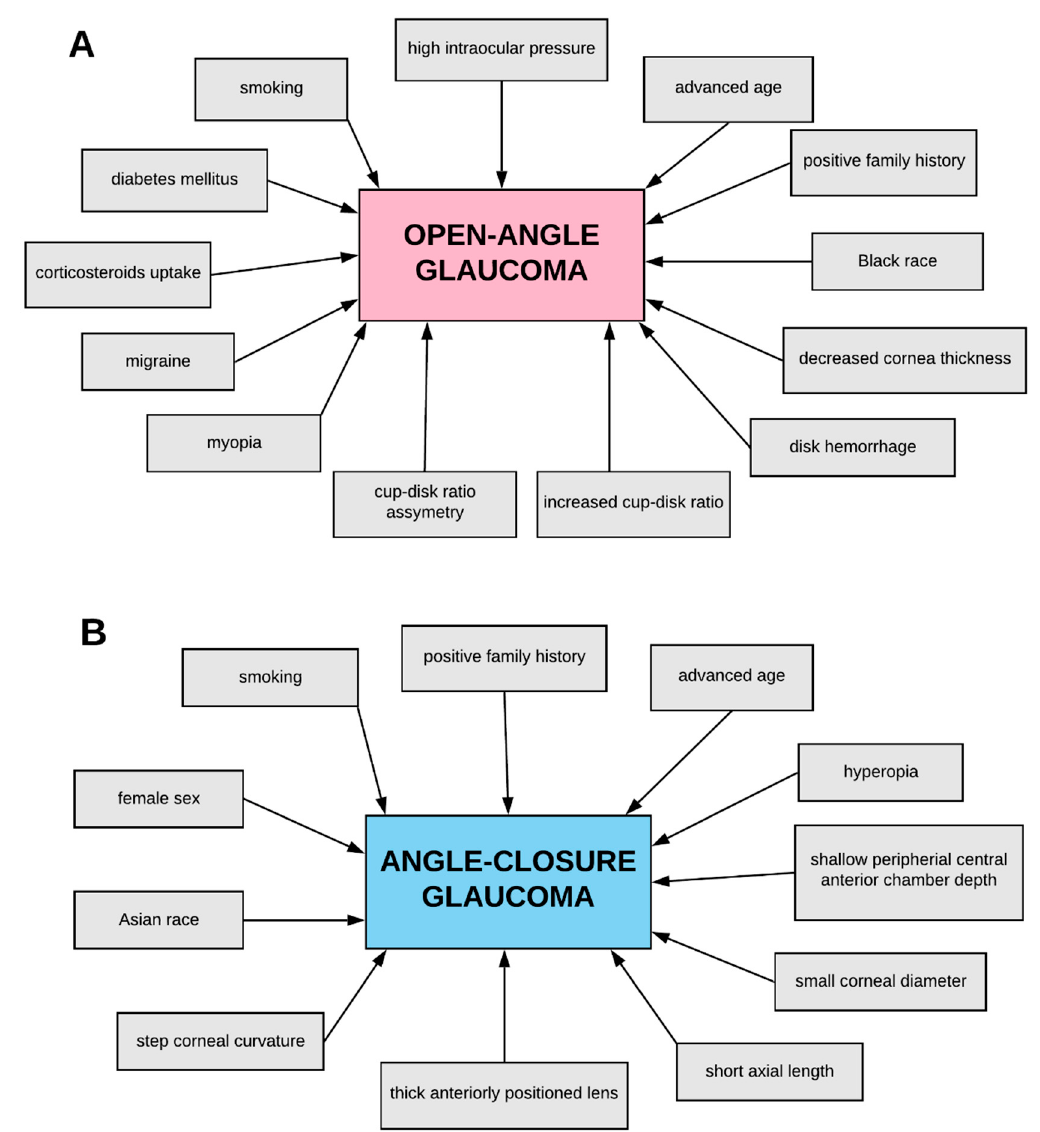
Figure 2. Risk factors for open-angle glaucoma (OAG) ( A ) and angle-closure glaucoma (ACG) ( B ).